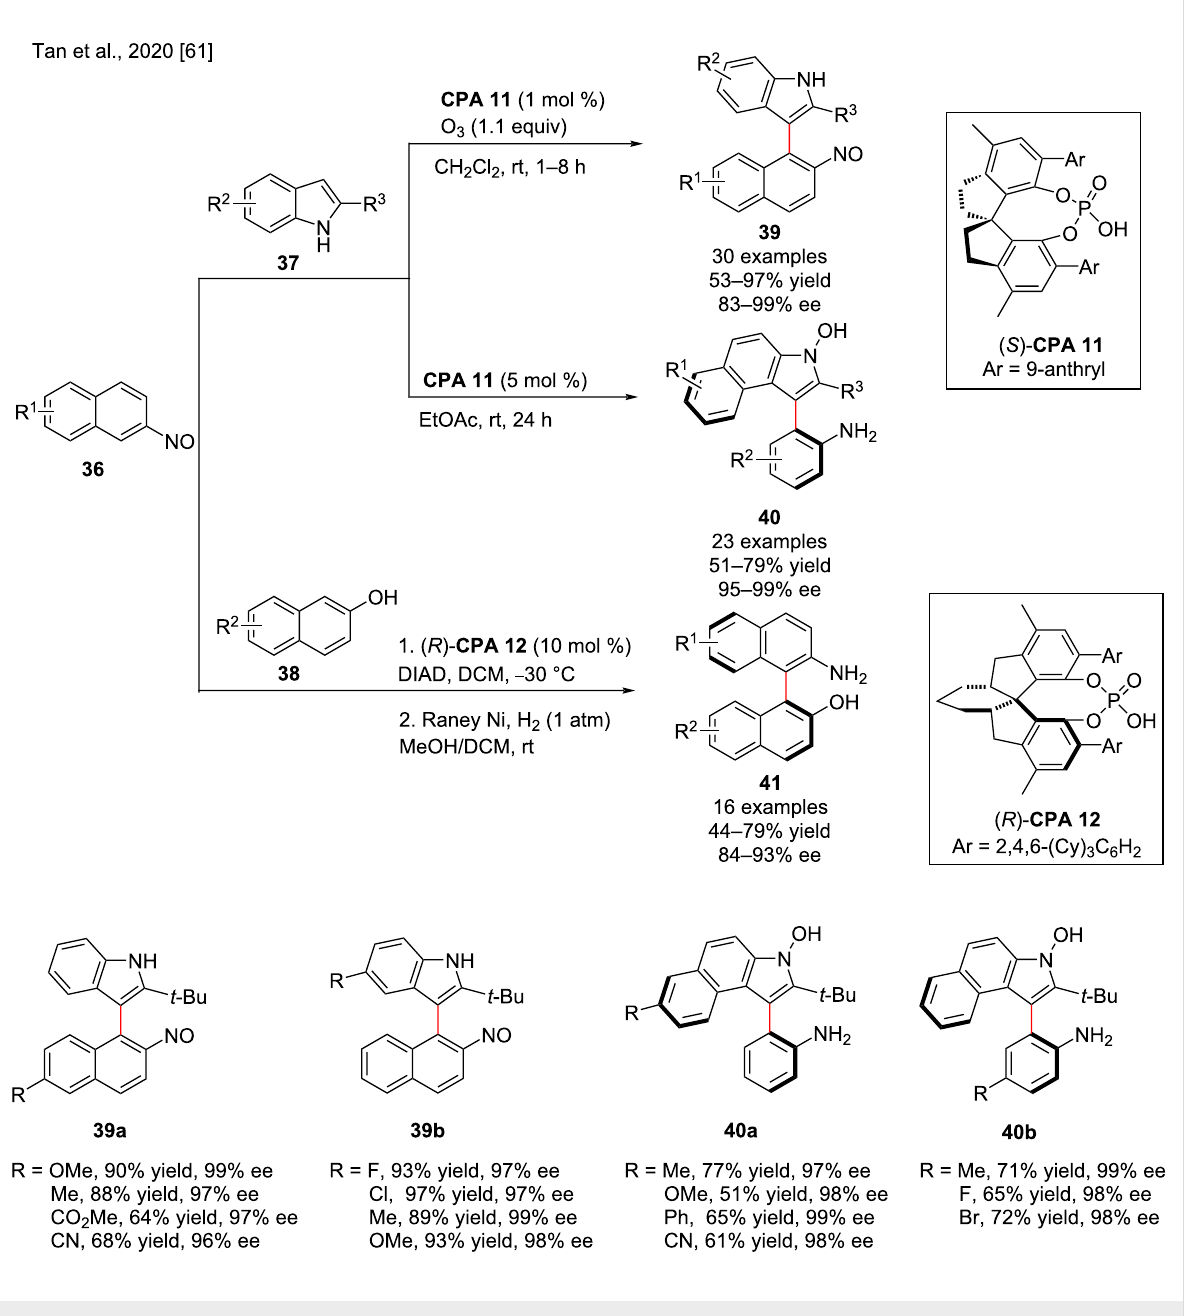
Scheme 13: Organocatalytic atroposelective arene functionalization of nitrosonaphthalene with indoles.